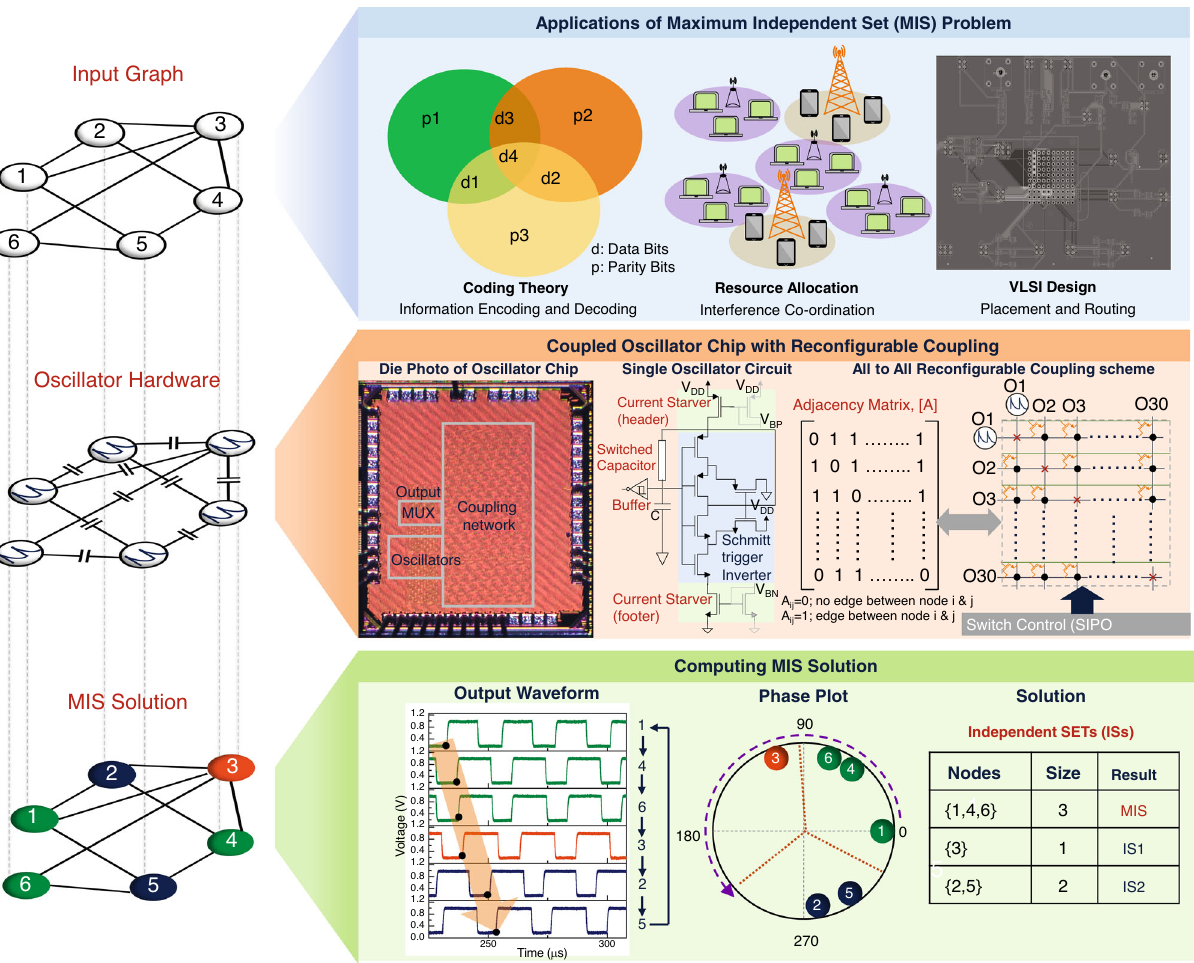
Fig. 1 Recon fi gurable coupled oscillator platform to solve maximum independent set (MIS). (Top panel) Solving the computationally hard MIS problem in graphs and its practical applications; (Middle panel) Features of the IC: Die photo, oscillator circuit schematic, and illustration of the all-to-all capacitive coupling scheme implemented in the IC; (Bottom panel) Experimental time domain waveform, phase sequence, and the independent sets computed from the coupled oscillator dynamics. The largest independent set approximates the